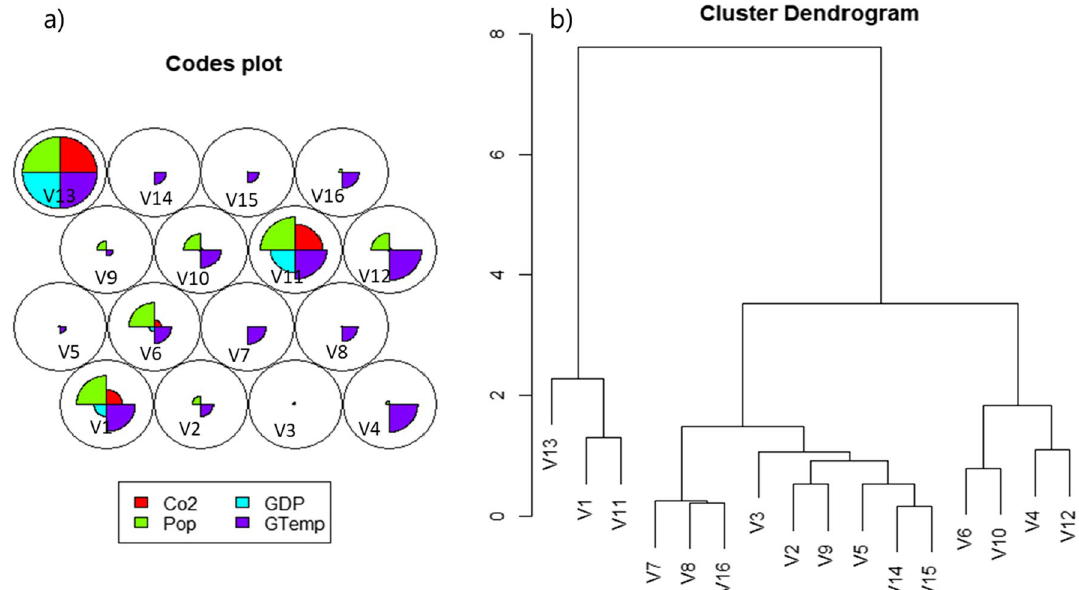
Fig. 4 Patterning and visualization of input data in a the self‑organizing map (SOM) code plot in (4 × 4) grids and b cluster dendrogram of SOM output ( V i is the SOM output cluster of i th